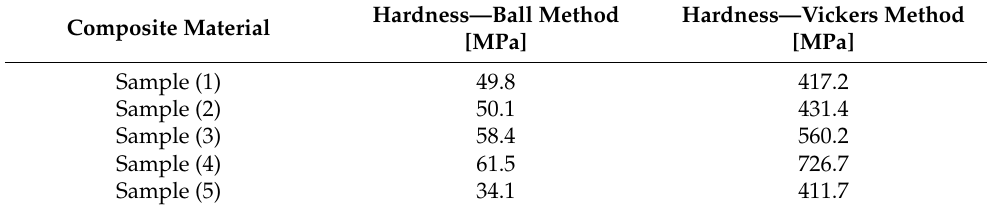
Table 2. Hardness.